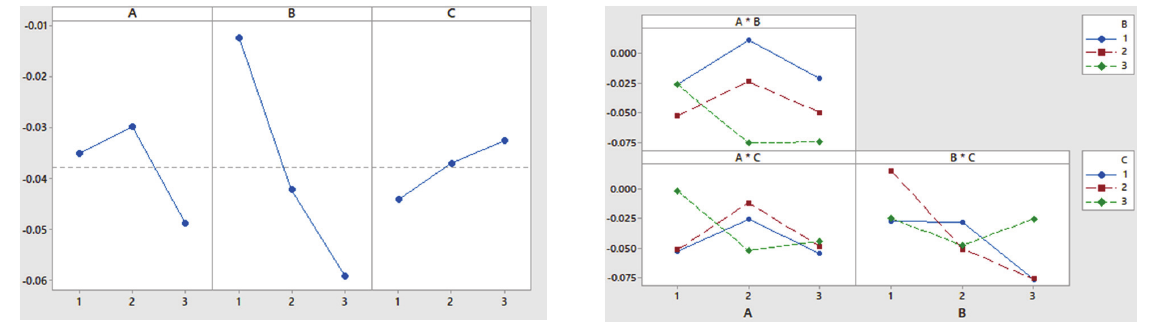
Fig. 14. Effect analysis - Average